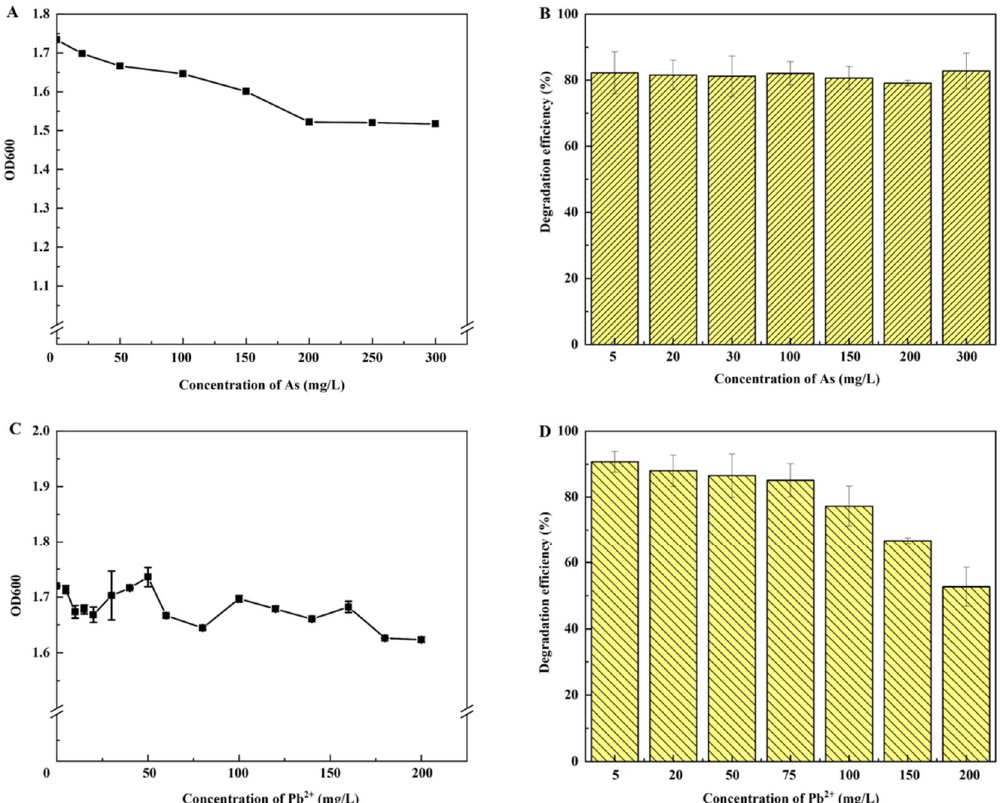
Figure 4. Effects of different heavy metal concentrations on strain JYZ-03 growth and petroleum hydrocarbon degradation. ( A ) Effects of As(V) on strain JYZ-03 growth; ( B ) petroleum hydrocarbon degradation by strain JYZ-03 at various As concentrations; ( C ) effects of Pb 2+ on strain JYZ-03 growth; ( D ) petroleum hydrocarbon degradation by strain JYZ-03 at various Pb 2+ concentrations.